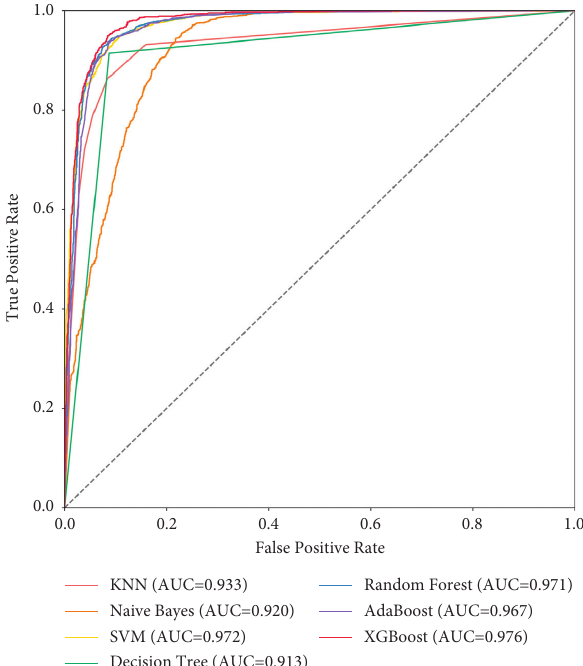
Figure 7: ROC curves for the different classifiers. The AUC values for each model have been